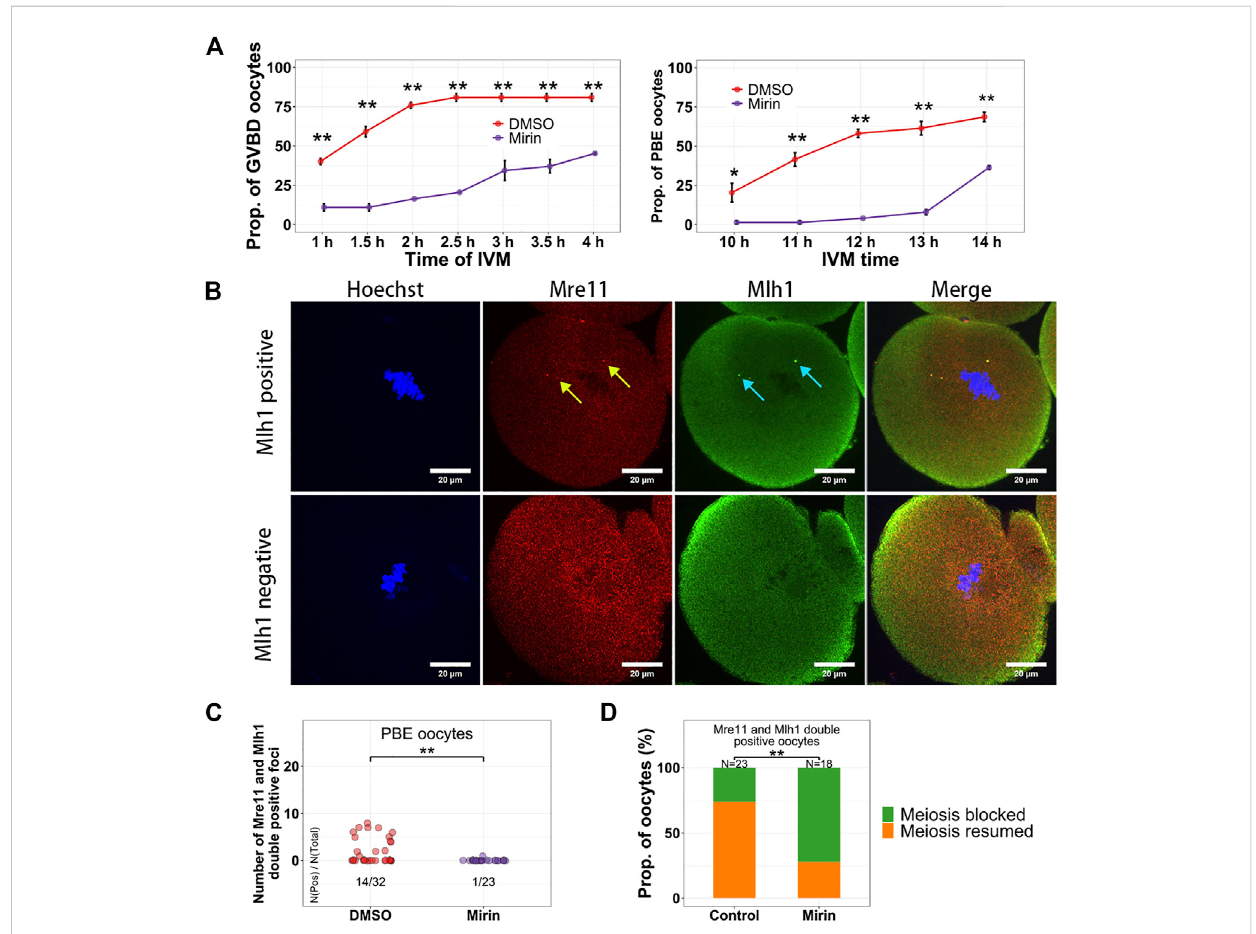
Mirin suppresses the meiosis resumption of growing oocytes. (A) Oocytes were treated with Mirin for 12 h in Milrinone, and then released from Milrinone for invitro maturation. GVBDand PBEof oocytes are suppressed byMirin. (B) Mlh1 and Mre11 focican bedetected in theMII (metaphase ofthe second meiosis) oocytes. (C) Compared with control (DMSO) group, the Mre11 and Mlh1 focus positive PBE oocytes are decreased in the Mirin treated group. (D)